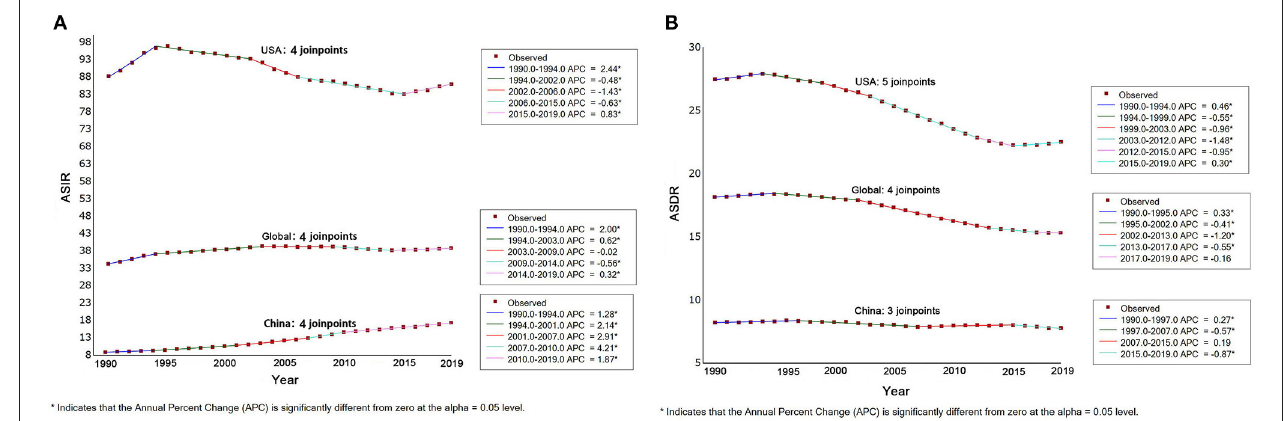
FIGURE 2 | The the results of joinpoint regression analysis for age-standard incidence rate (A) and death rate (B) protate cancer in global, China and America from 1990 to 2019.